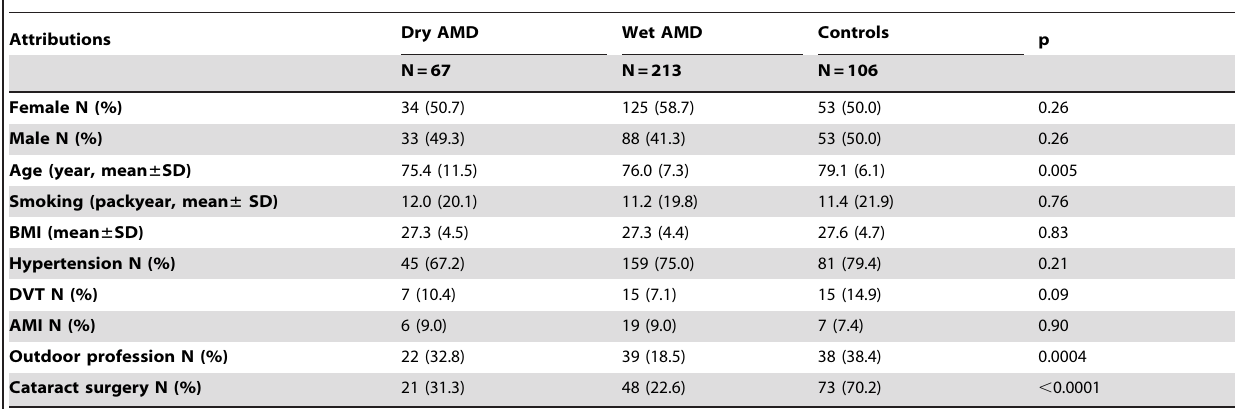
Table 1. Characteristics of the study